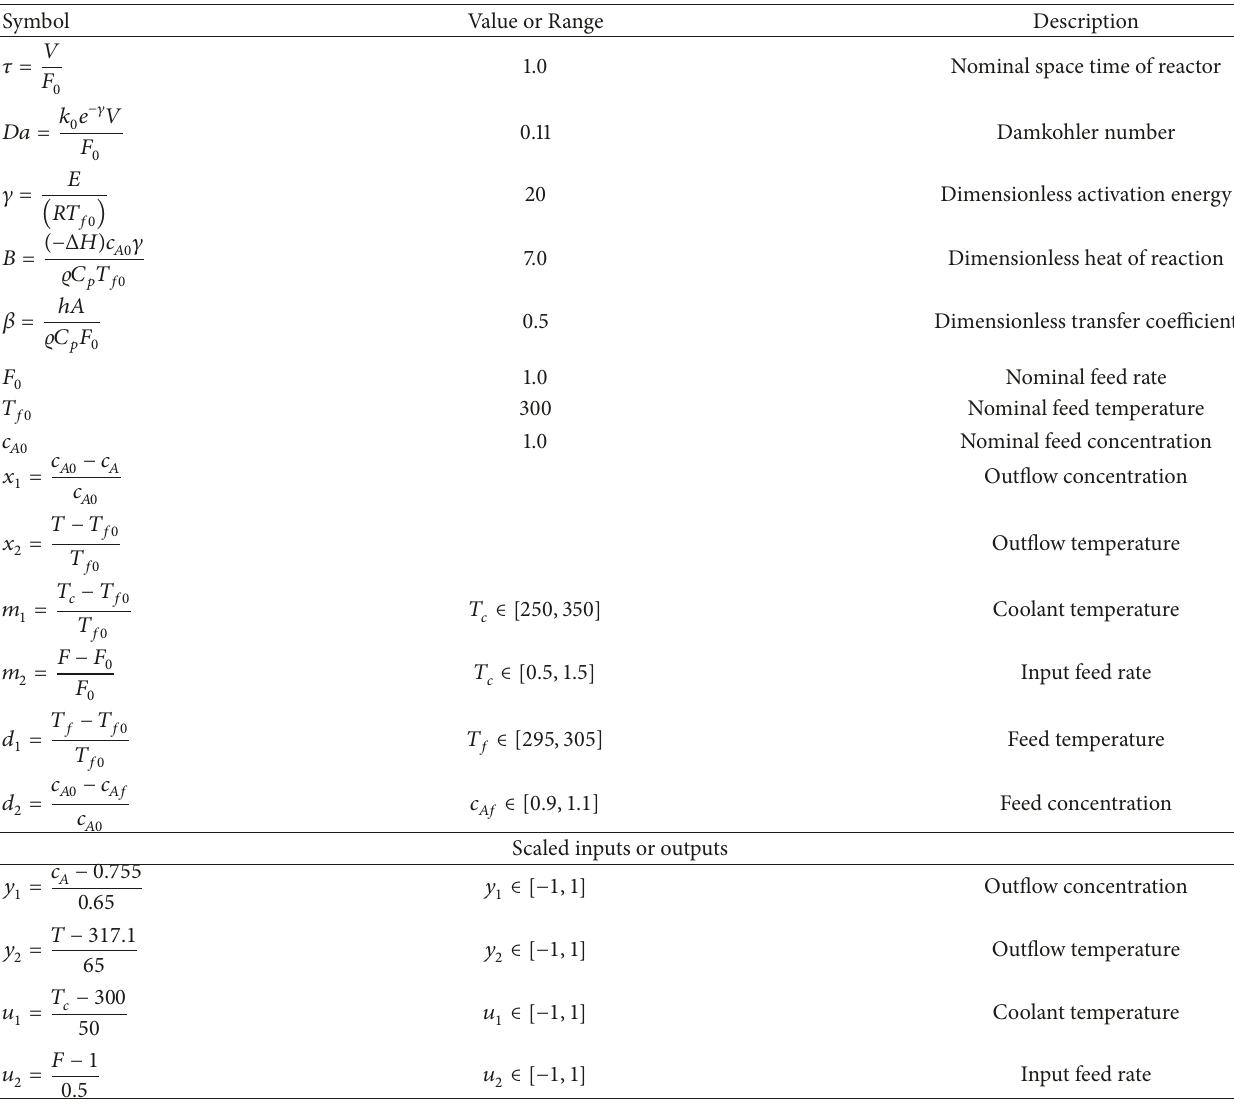
Table 2: Summary of parameters and variables in the CSTR model for Case 2.